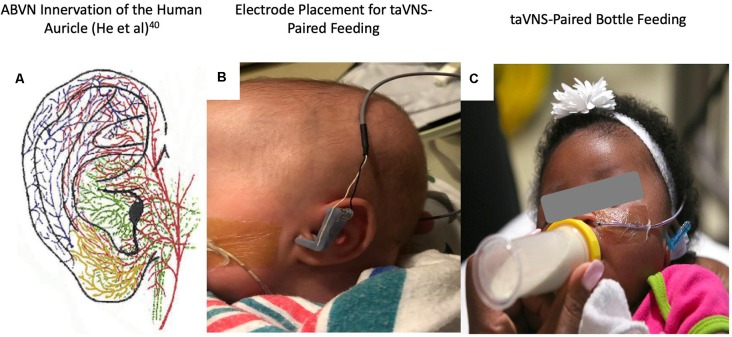
(A) Auricular vagus nerve fibers (He et al., 2012). (B) Close-up photo of the left ear with attached custom, 3D-printed transcutaneous auricular vagus nerve stimulation (taVNS) electrodes attached. (C) Photo of the taVNS-paired feeding session with stimulation delivered concurrently with bottle feeding (written informed consent was obtained from the legal guardians for the publication of this image).